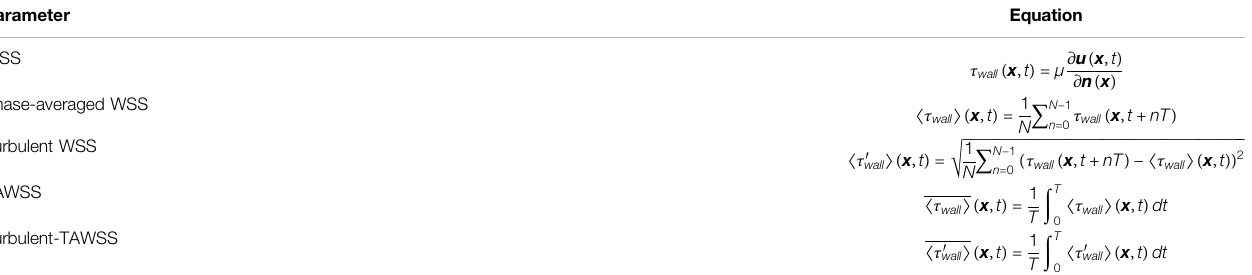
TABLE 2 | Wall shear stress parameter de fi nitions.